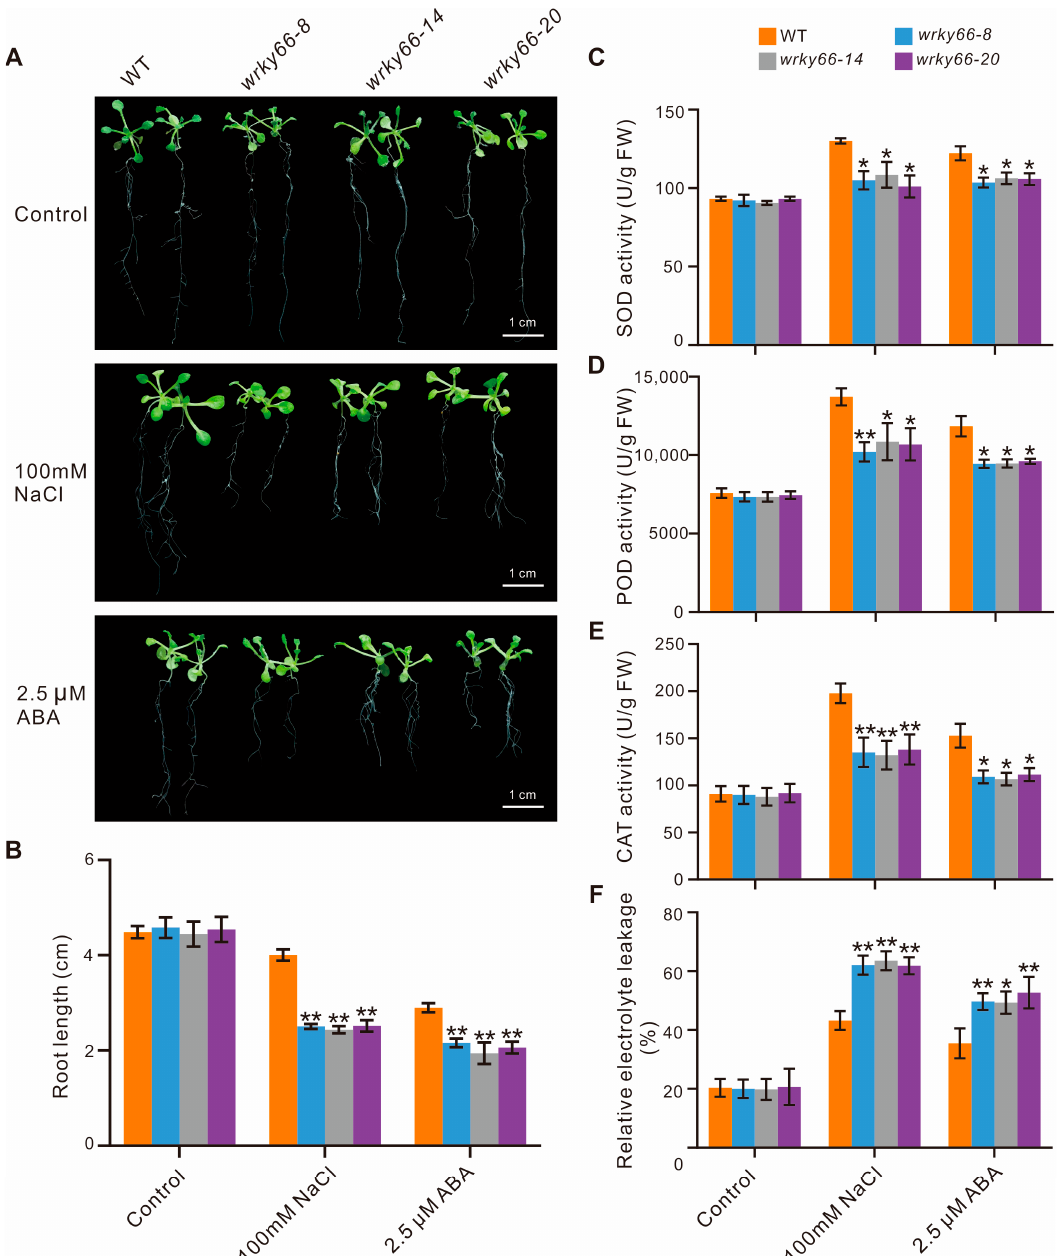
Figure 5. Decreased tolerance to salt stress and ABA in the AtWRKY66 knockdown plants. ( A ). Phe- notypic characteristics of the wrky66 and WT seedlings under salt stress and ABA treatments. Growth of the A. thaliana plant on 1/2 MS solid medium (control) and 1/2 MS solid medium supplied with 100 mM NaCl or 2.5 µ M ABA. ( B ). Root lengths were measured at eleven days after germination (i.e., after treatment with NaCl or ABA two days). ( C – F ). SOD, POD, CAT activity and REL of the mutant and WT seedlings under salt stress and ABA treatments, respectively. Control represented a normal growth condition. The error bars indicate the standard deviation from triplicate experiments. Asterisks indicated significant difference of the wrky66 plants compared with the WT plants under the NaCl and ABA treatments (* p < 0.05; ** p < 0.01). WT, wild type; SOD, superoxide dismutase; POD, peroxidase; CAT, catalase; REL, Relative electrolyte leakage; FW, fresh